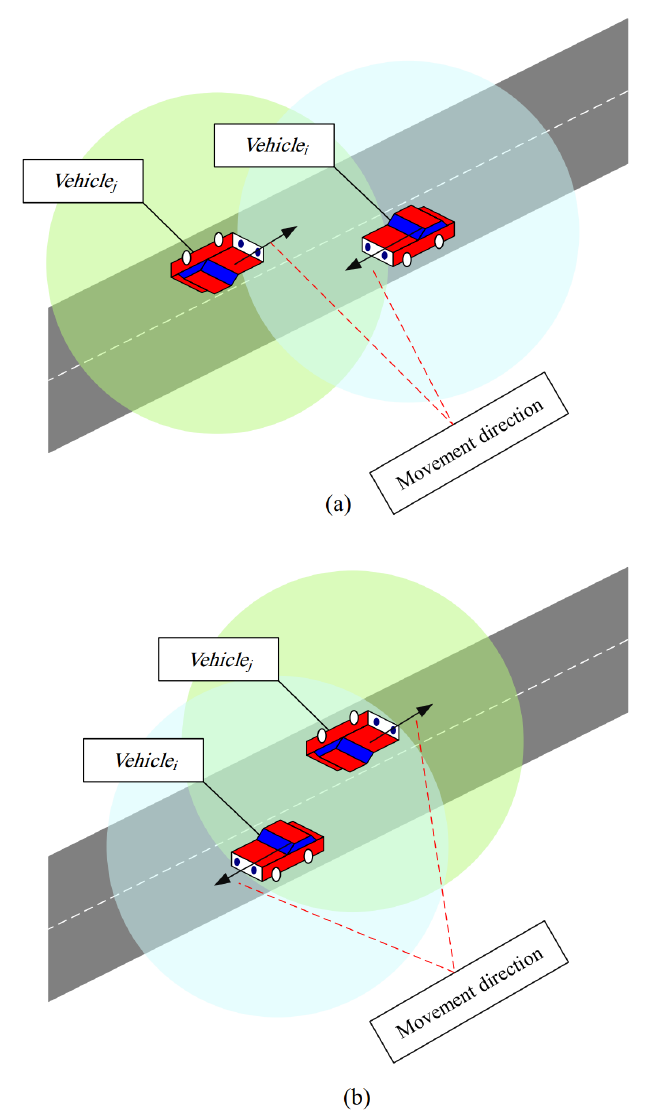
Figure 6. The movement of vehicles in the opposite direction ( a ) Vehicle i approaches Vehicle j . ( b ) Vehicle i gets away from Vehicle j